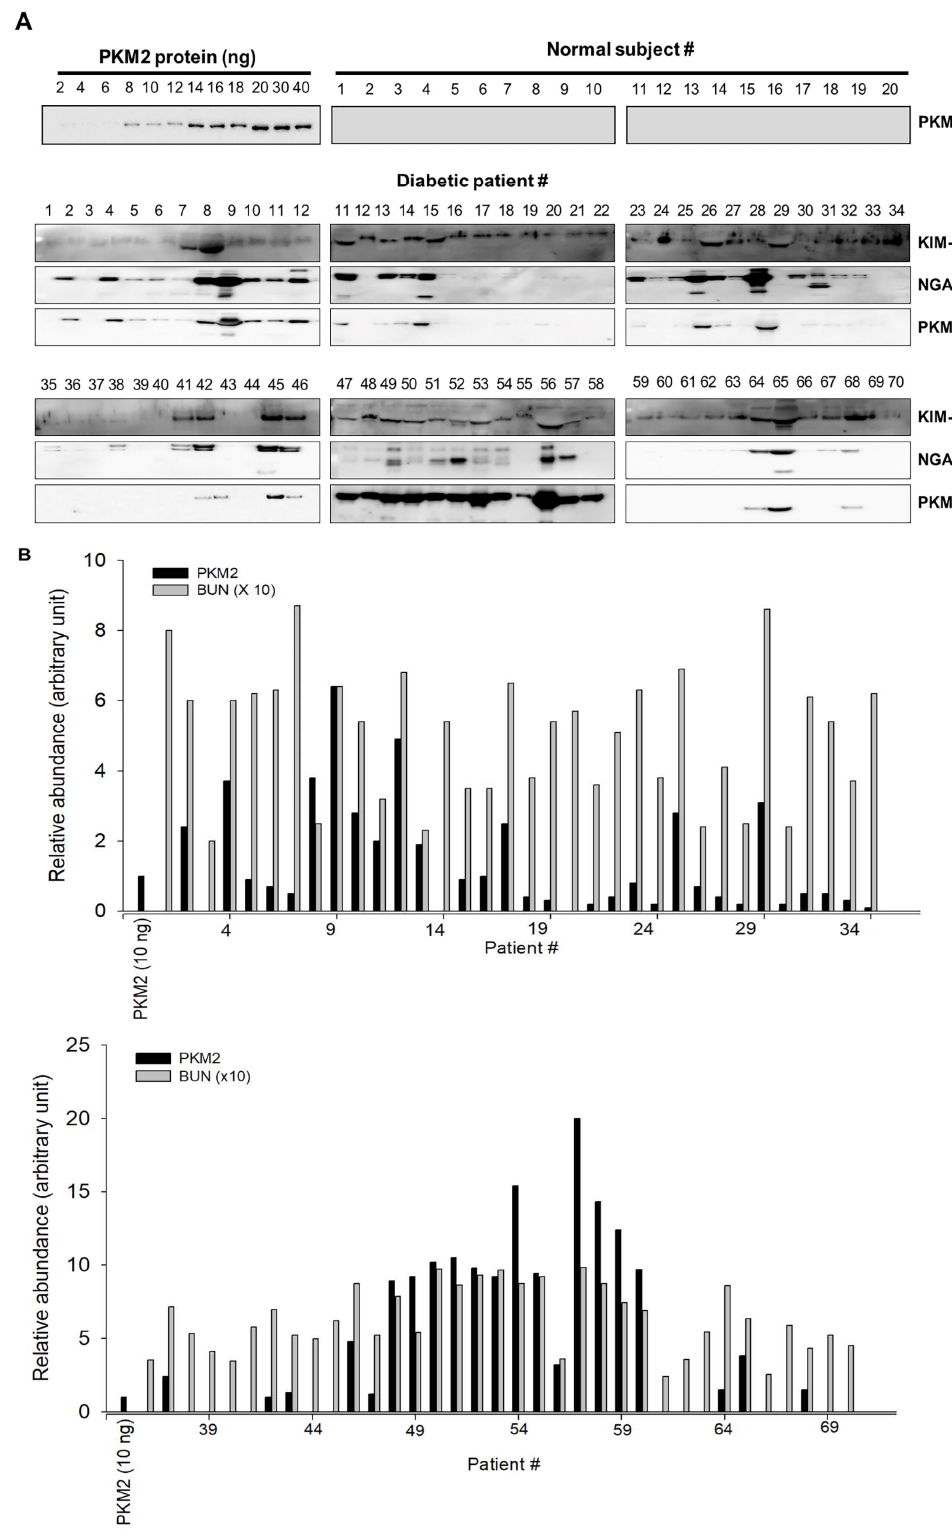
Figure 4. Urinary excretion of protein-based nephrotoxicity biomarkers in both normal subjects and patients with diabetes. ( A ) KIM-1, NGAL, and PKM2 levels were measured in the urine of healthy controls ( n = 20) and patients with diabetes ( n = 70) using western blot analysis. Urine proteins were resolved in 10% sodium dodecyl sulphate-polyacrylamide gel electrophoresis (SDS-PAGE) and analyzed using western blotting . ( B ) Densitometry analysis of the PKM2 band intensities in the urine of patients was normalized for 10 ng of recombinant protein PKM2.